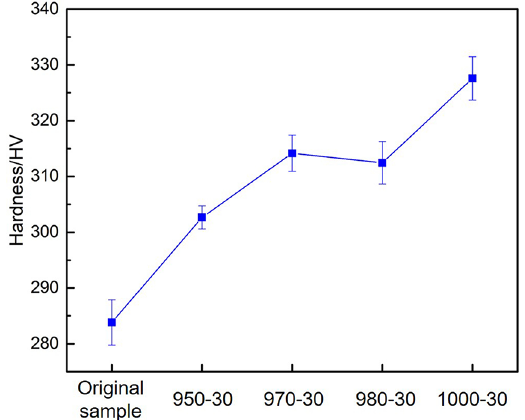
Figure 1. The harness of initial and annealed Ti-5Nb-5Al alloy at different